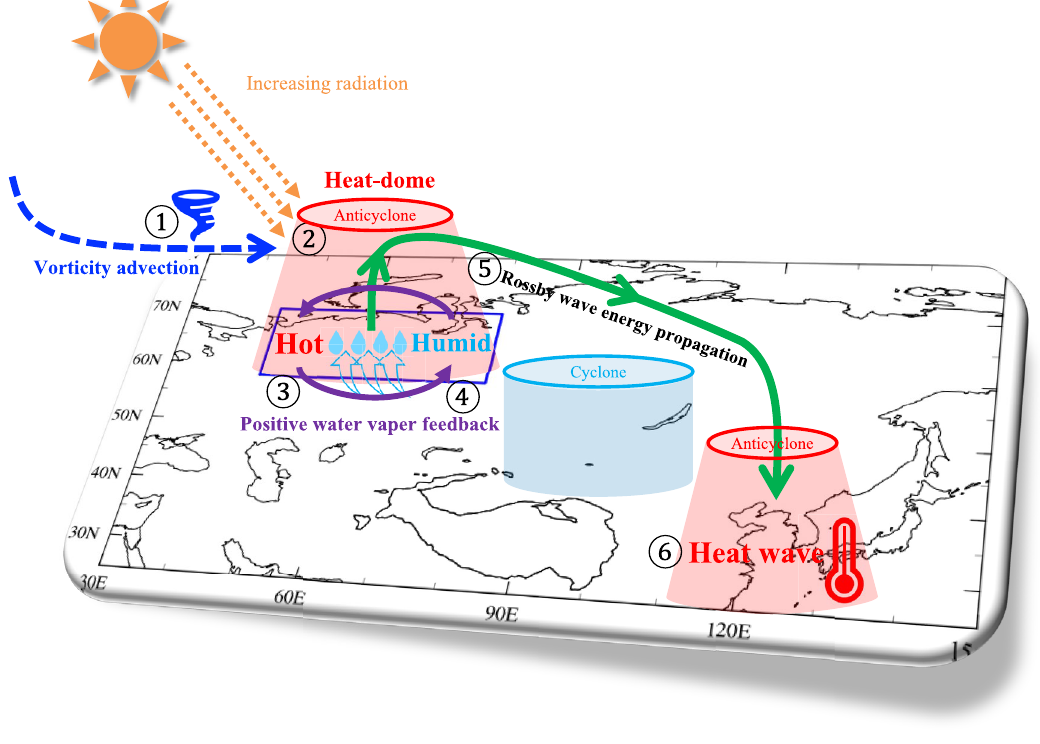
Figure 5. Schematic diagram of East Asian heat waves associated with Arctic-Siberian Plain warming. The blue dashed line indicates vorticity advection, and the solid green and purple lines indicate a Rossby wave energy pathway and the positive water vapor feedback, respectively. The numbers indicate the ordering of the